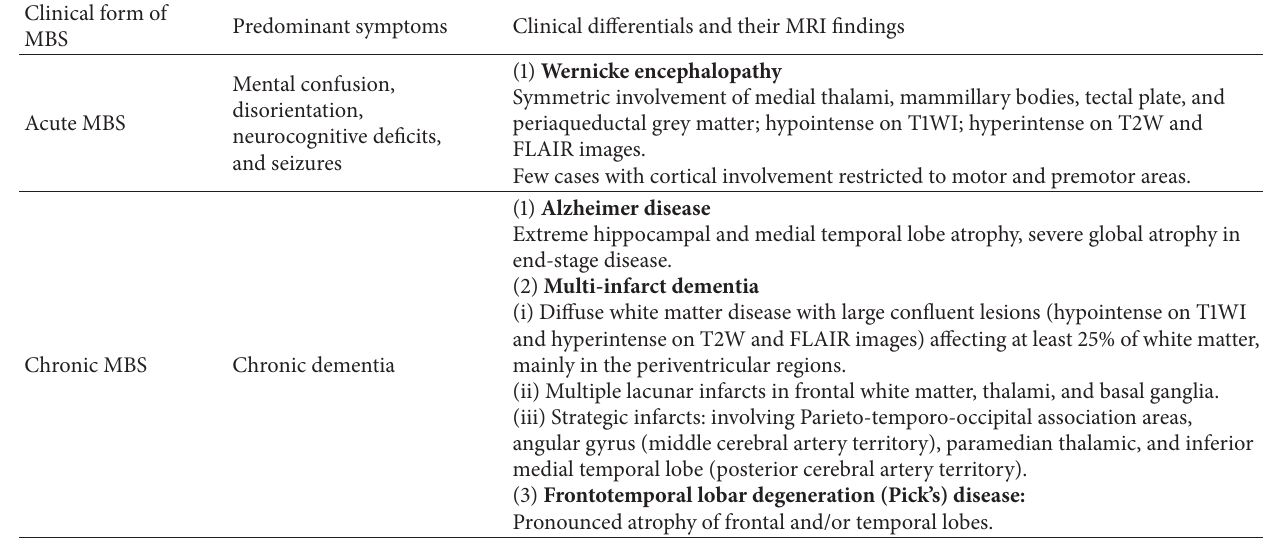
Table 1: Clinical forms of MBS and their differentials [1].